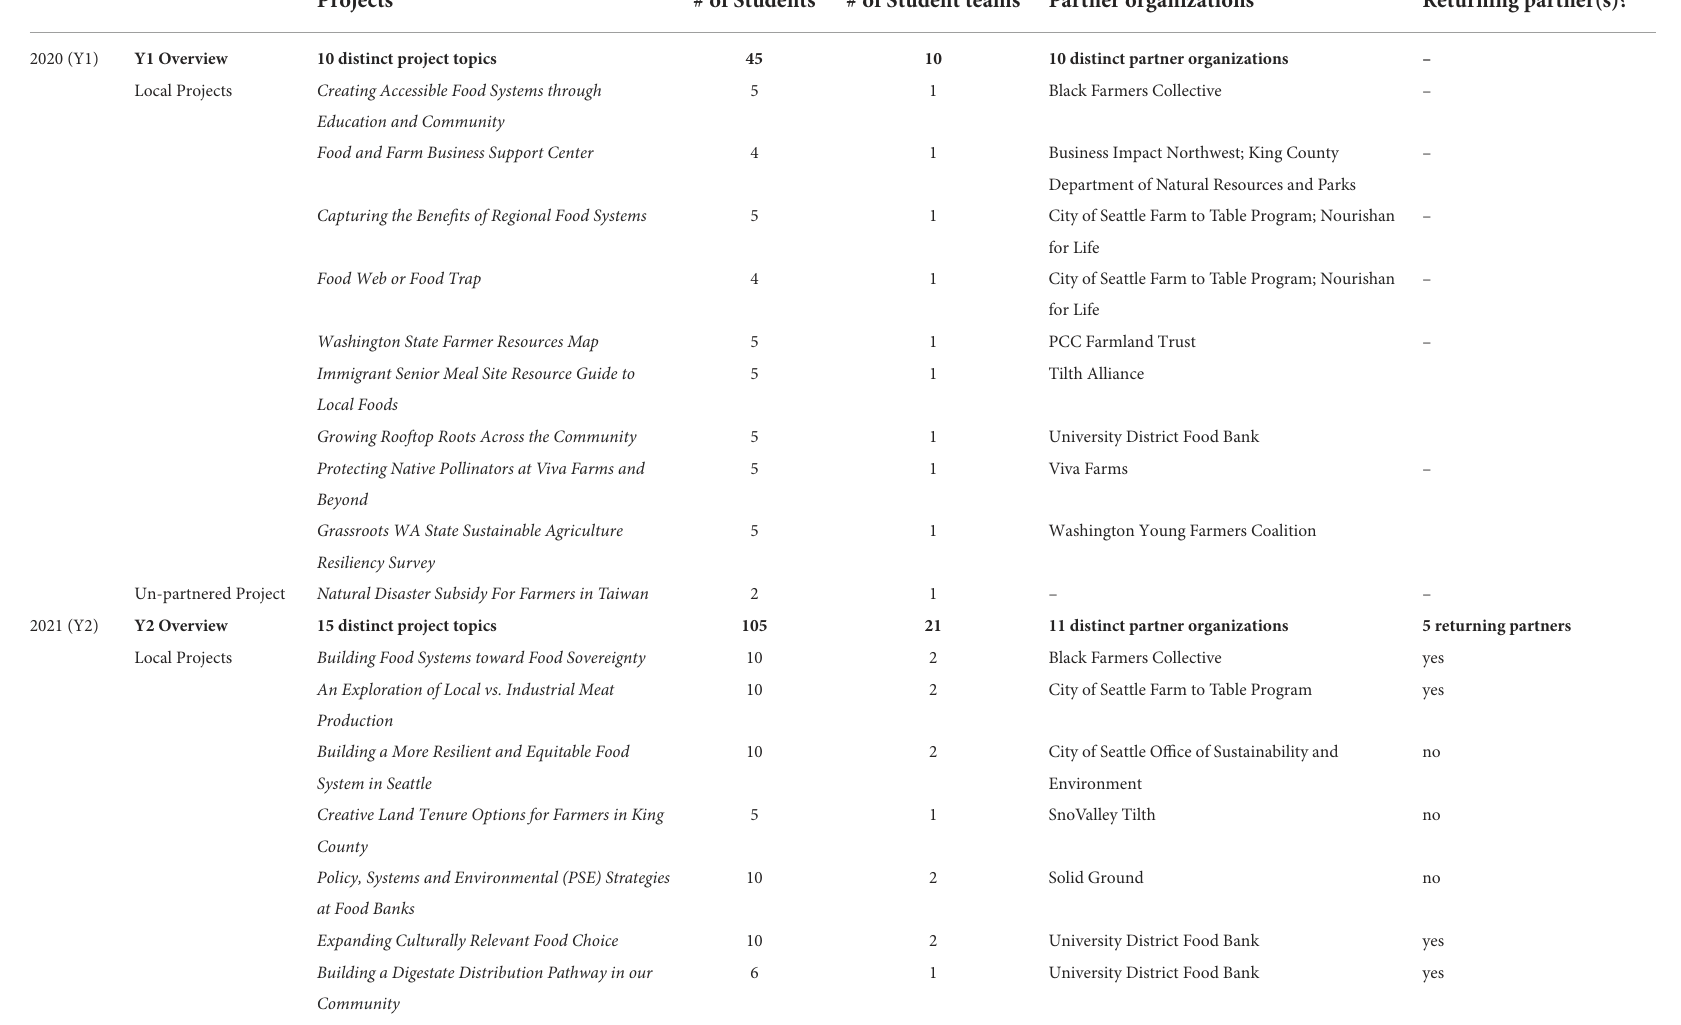
TABLE 1 An overview of the community partners and community-engaged food system projects from the University of Washington Food Systems Capstone (NUTR 495) in 2020 and 2021.